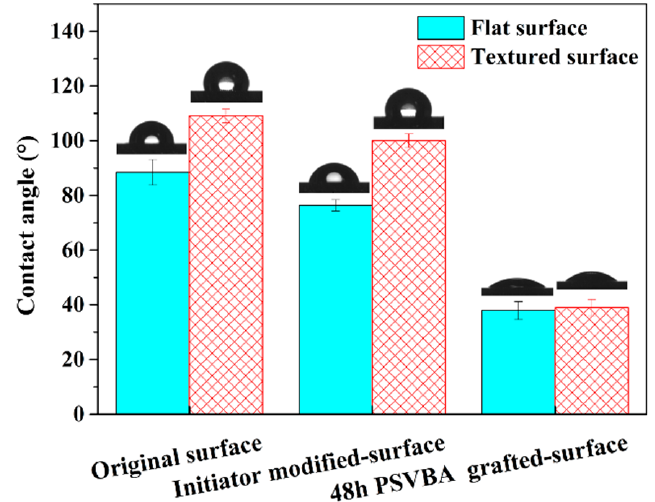
Figure 6. Static contact angles of Si surfaces in saturated NaCl solution with di ff erent